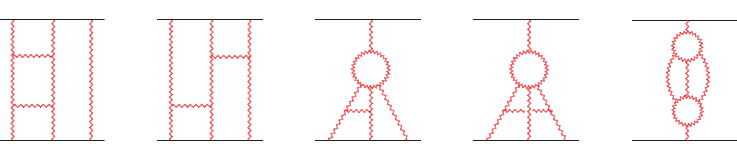
Figure 4: Representation of transitions involving Multi-Reggeon States (MRS), which contribute to the odd-signature amplitude at four loops. Figure taken from [ 23